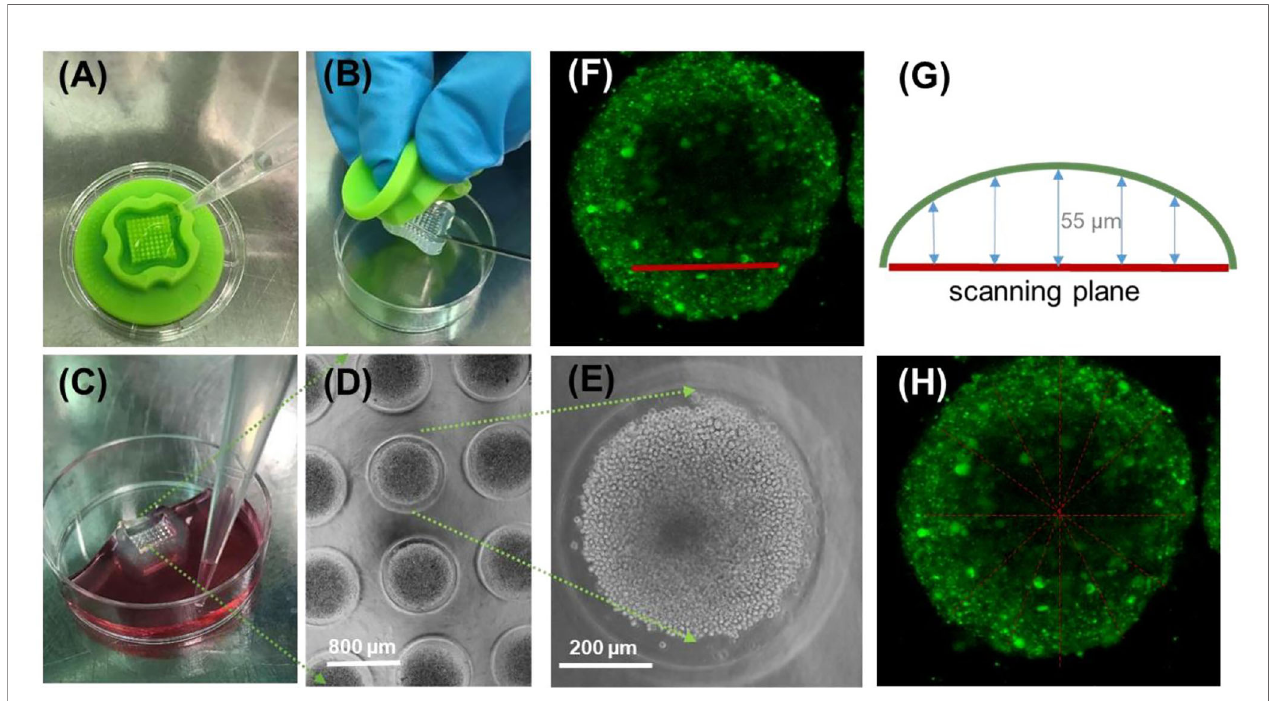
FIGURE 2 | Schematic work fl ow using the micromolded nonadhesive agarose 3D Petri dish to evaluate Cf -peptide penetration ability to EBC-1 spheroid tissue- mimicking model. Imaging and analysis of spheroids (A, B) ; 9 × 9-type silicone micromold used for casting agarose Petri dish (C) , equilibrating and adding complete cell medium. View of EBC-1 spheroids in agarose 3D Petri dish (D) , enlarged image of an individual EBC-1 spheroid (E) ; (D, E) bright- fi eld images were captured with an Olympus CX41 microscope [objective: ×4 (D) and ×20 (E) ]. Side view of an EBC-1 spheroid with the position of scanning plane (G) during confocal laser scanning microscopy imaging (section z5, corresponding to z-section captured 55 µm from the surface) (F) . Position of lines during linescan of section z5 of two parallel spheroids (eight lines each) (H)